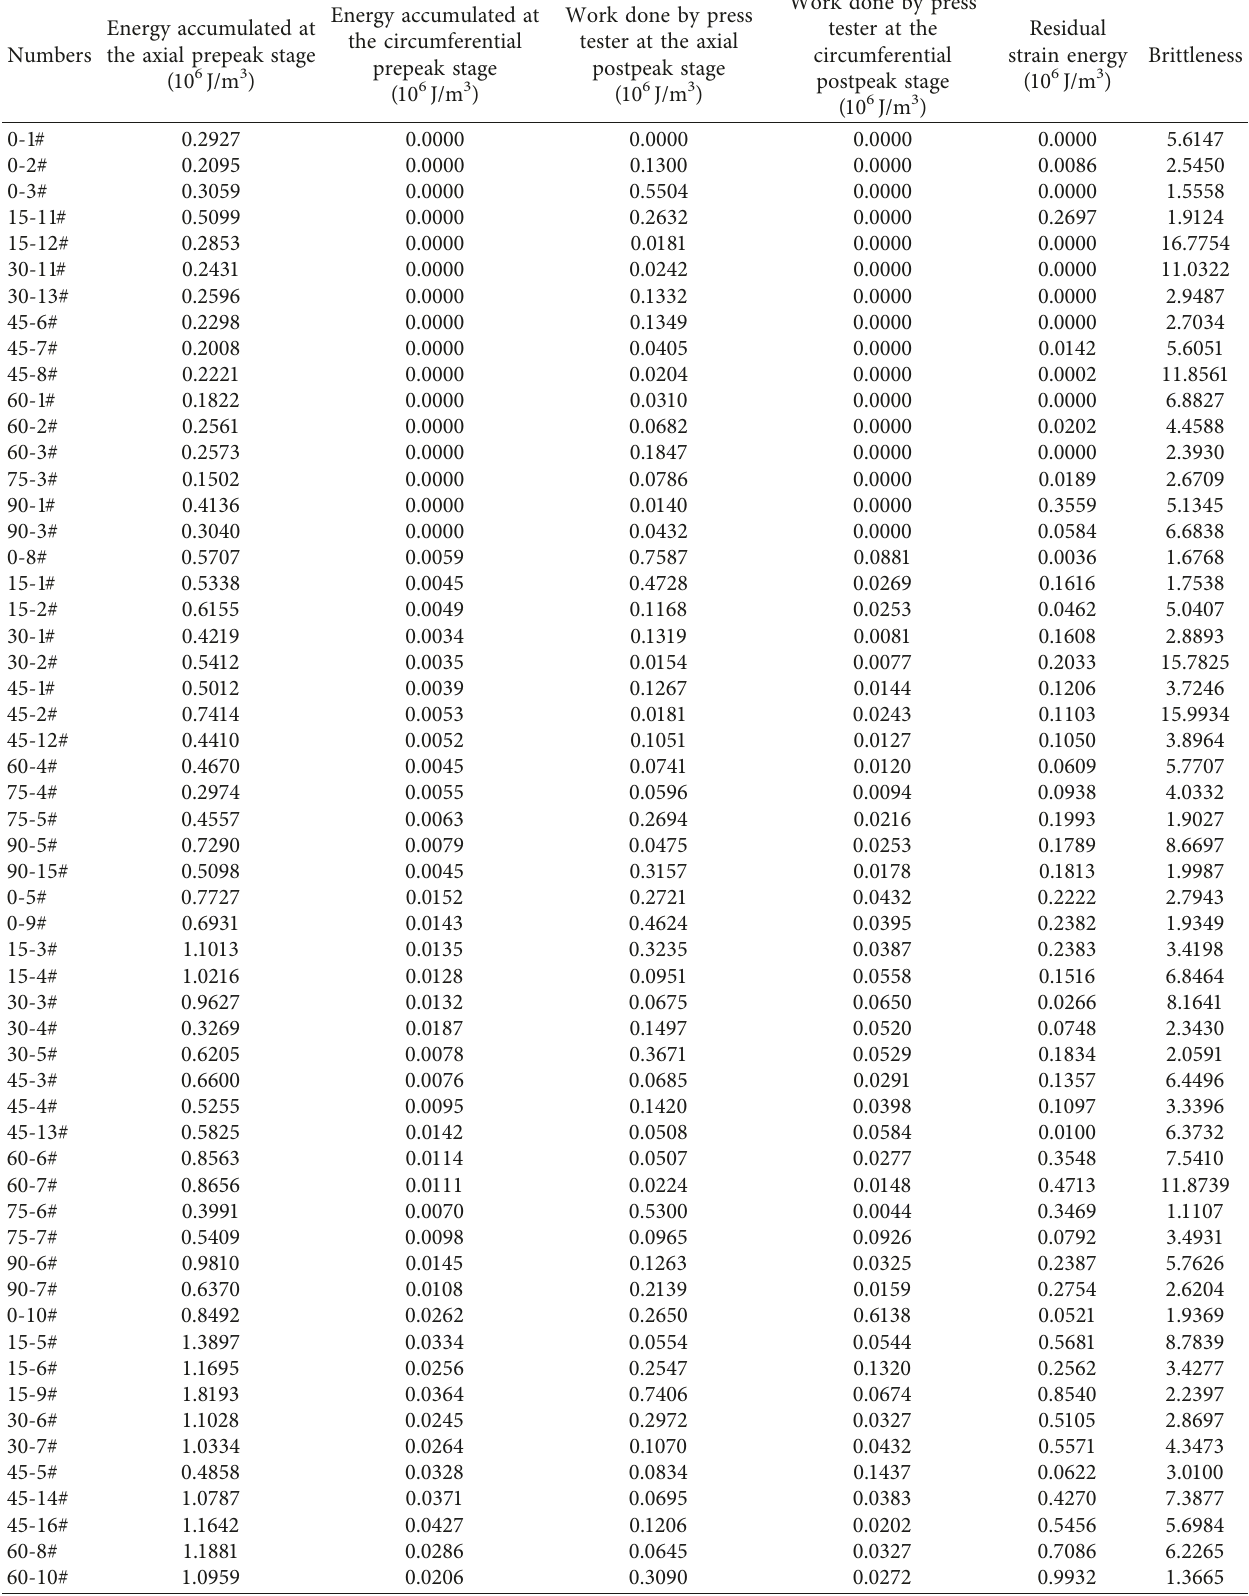
Table 1: The calculated slate brittleness